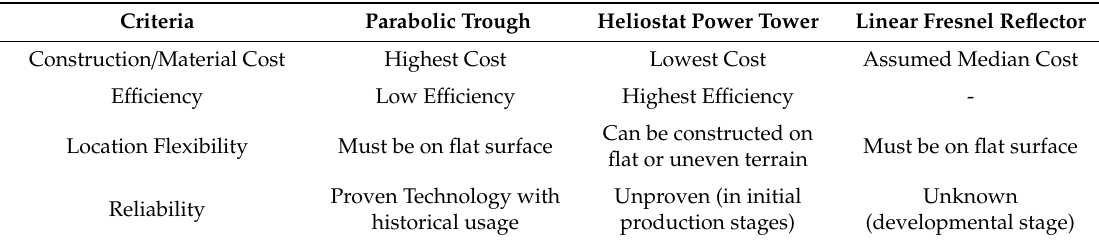
Table 2. Comparison among three concentrated solar power (CSP) technologies.